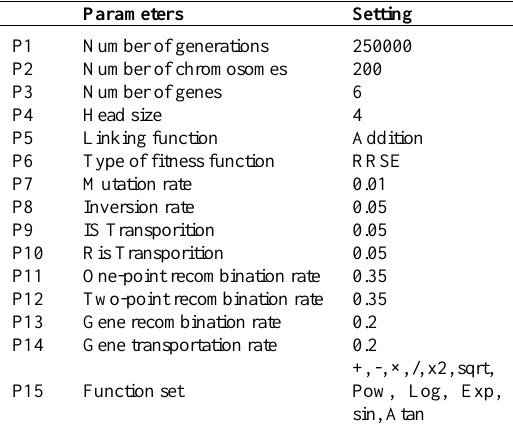
Table 1. Optimized values of key parameters related to the GEP model. Parameters